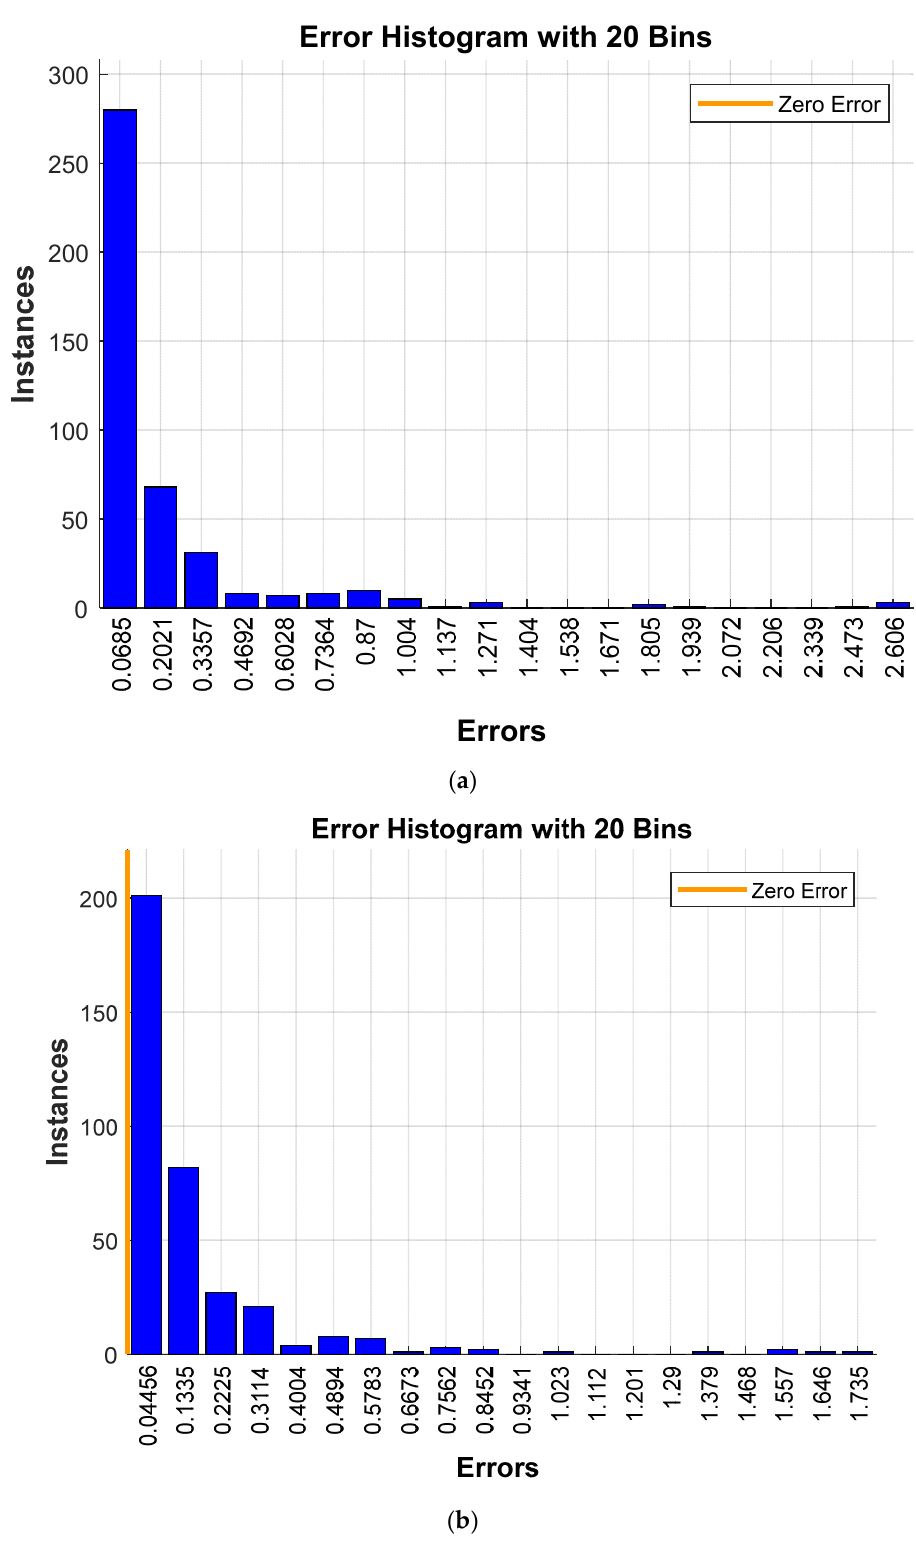
Figure 7. Error histograms for the BPANN model in cast-in-place tunnel liners and concrete portal. ( a ) Cast-in-place tunnel liners. ( b ) Concrete portal.